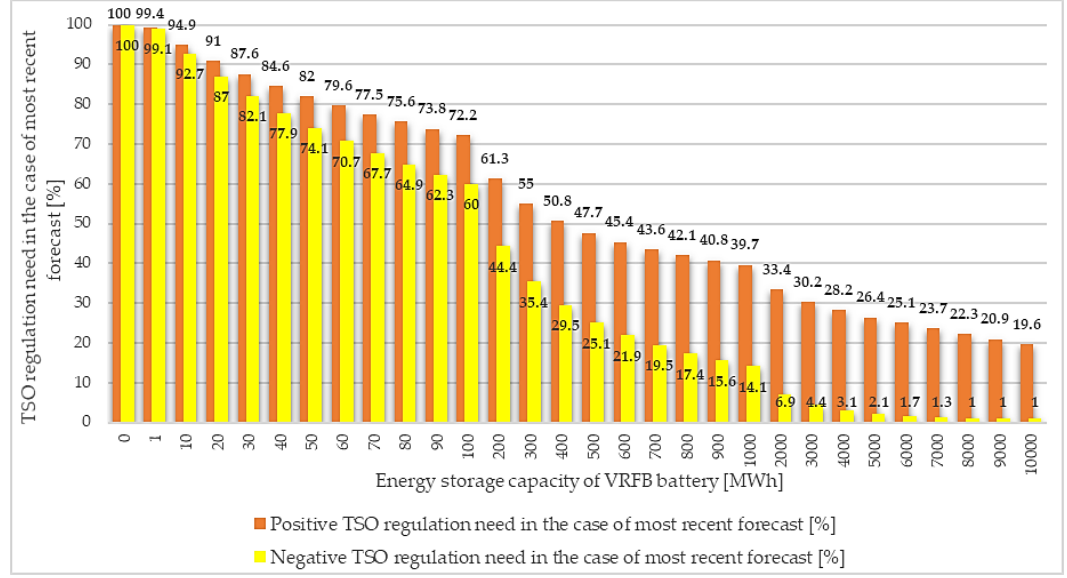
Figure 12. Negative and positive TSO regulation needs in the case of most recent forecast with different VRFB energy storage capacities related to a 1000 MWp PV system for the period of 30/09/2014–30/09/2019.